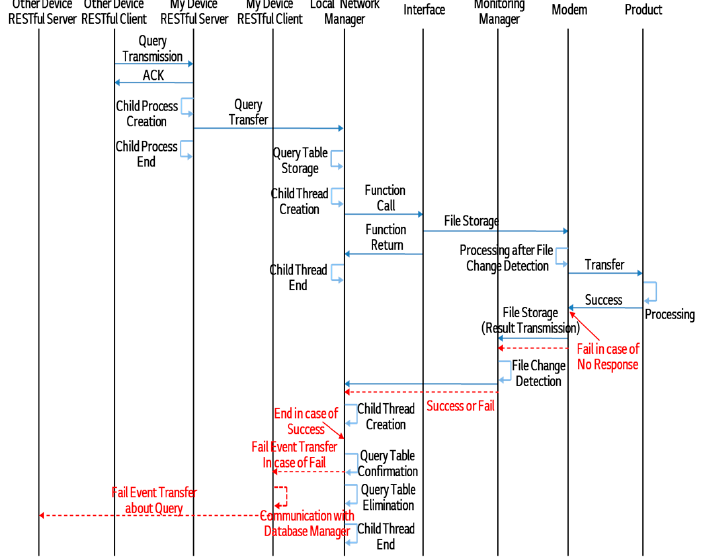
Figure 6. Protocol for receiving and processing queries (part-A).